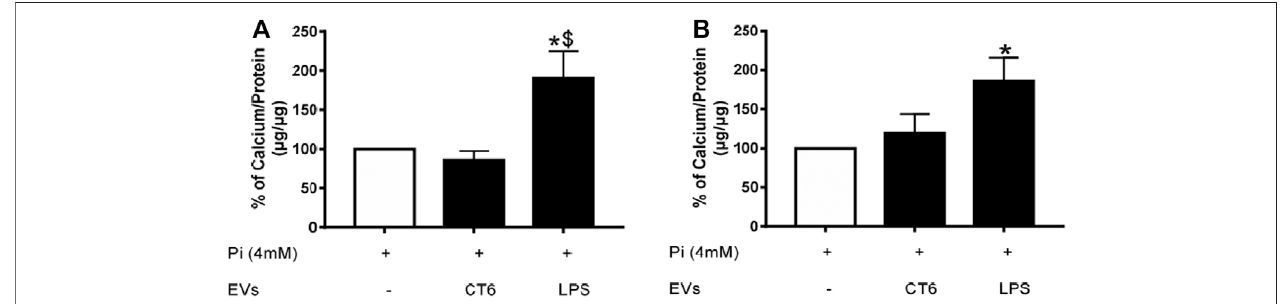
FIGURE 12 | EV-LPS enhance Pi-induced calci fi cation in smooth muscle cells. Calci fi cation in MOVAS-1 cells was induced by incubation with 4 mM Pi with or without RAW cell-derived EVs for (A) 14 days or (B) during the last 7 days of a 14-day calci fi cation induction. Calci fi cation was then measured using the OCP method. Dataare expressed asthe mean ± SEM offour independent experiments performed in triplicate ( n = 4). * p < 0.05 vs. 4 mM Pi,$ p < 0.05 vs. EV-CT, Mann-Whitney test. EV-CT: EVs derived from untreated macrophages, EV-LPS: EVs derived from LPS-EK-treated macrophages.